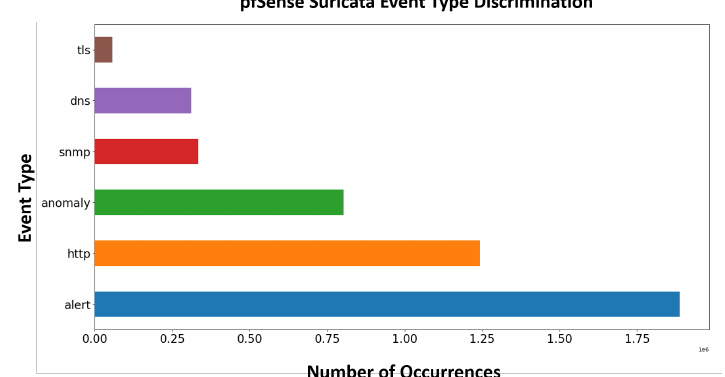
Figure 6. <Event> Attribute